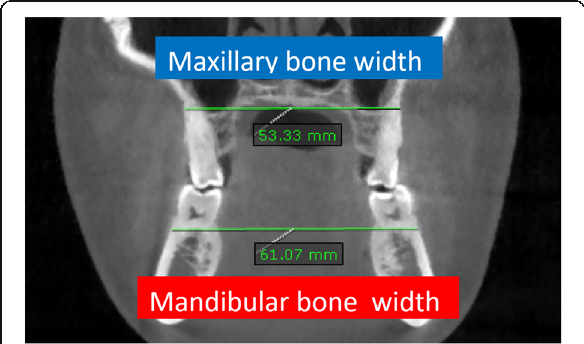
Fig. 1 The maxillary bone width is determined by the distance between the right and left bony points at the level of the mesiobuccal root tips of the first molars. Mandibular bone width was defined as the distance between the right and left bony buccal surface at the level of the furcation of first molars. The maxillomandibular bone width discrepancy is obtained by subtracting mandibular bone width (61.07 mm) from the maxillary bone width (53.33) = − 7.74 mm